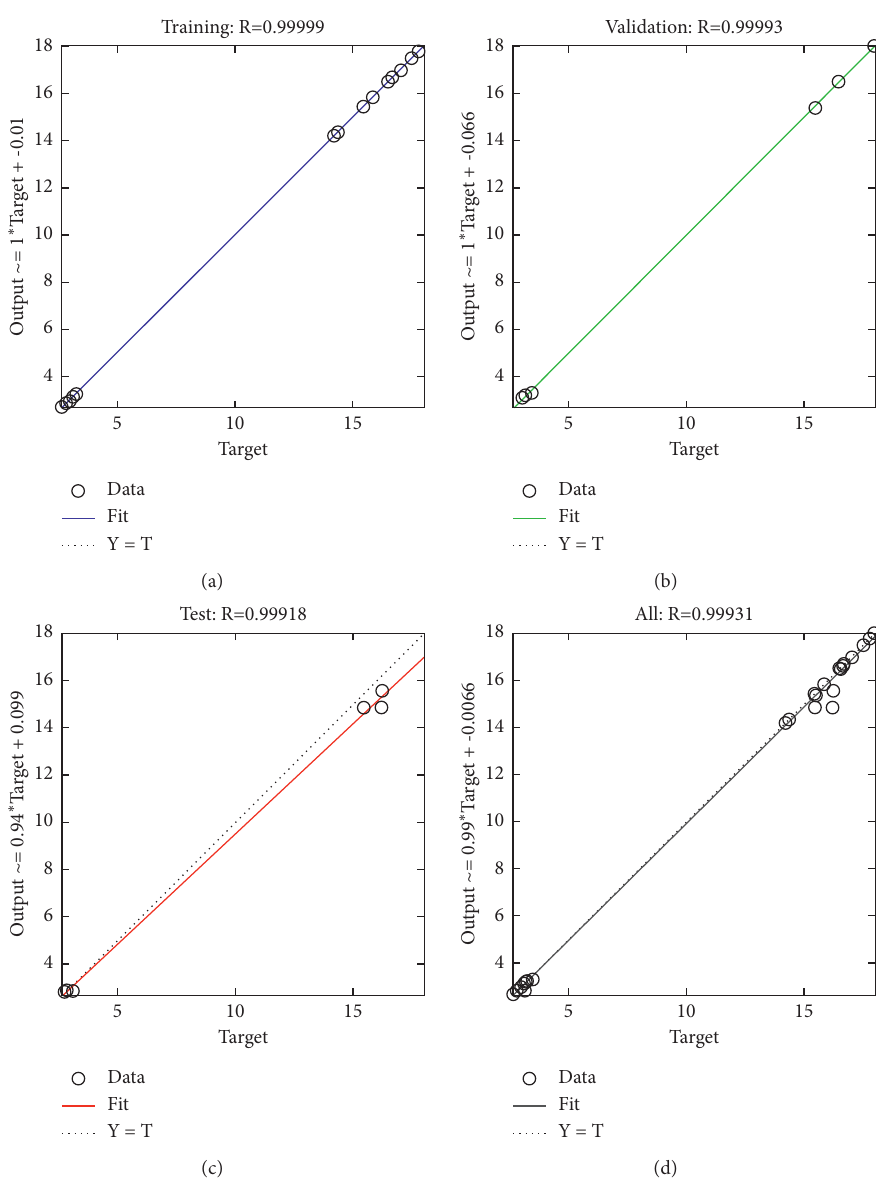
Figure 9: Output of ANN model: (a) Training, (b) validation, (c) testing, (d) complete